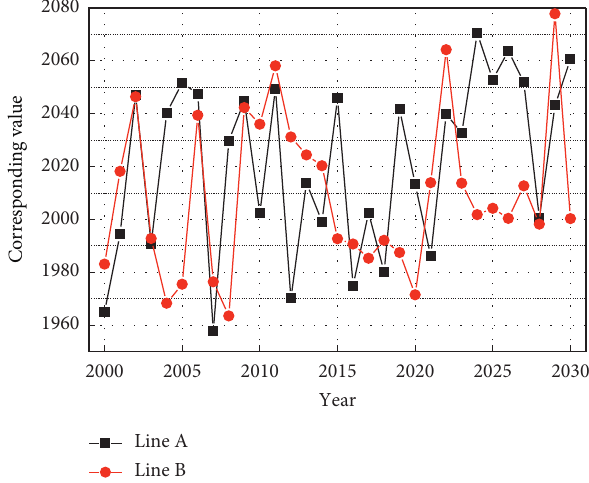
Figure 7: Impact of CASH project investment on GDP.